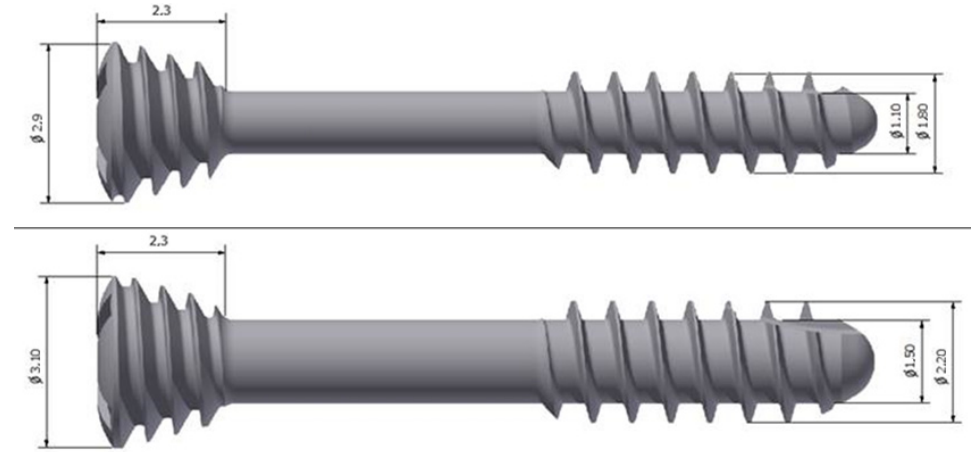
Figure 3. Two types of headless compression screws were used in this study: 1.8 titanium and 2.2 magnesium by ChM.